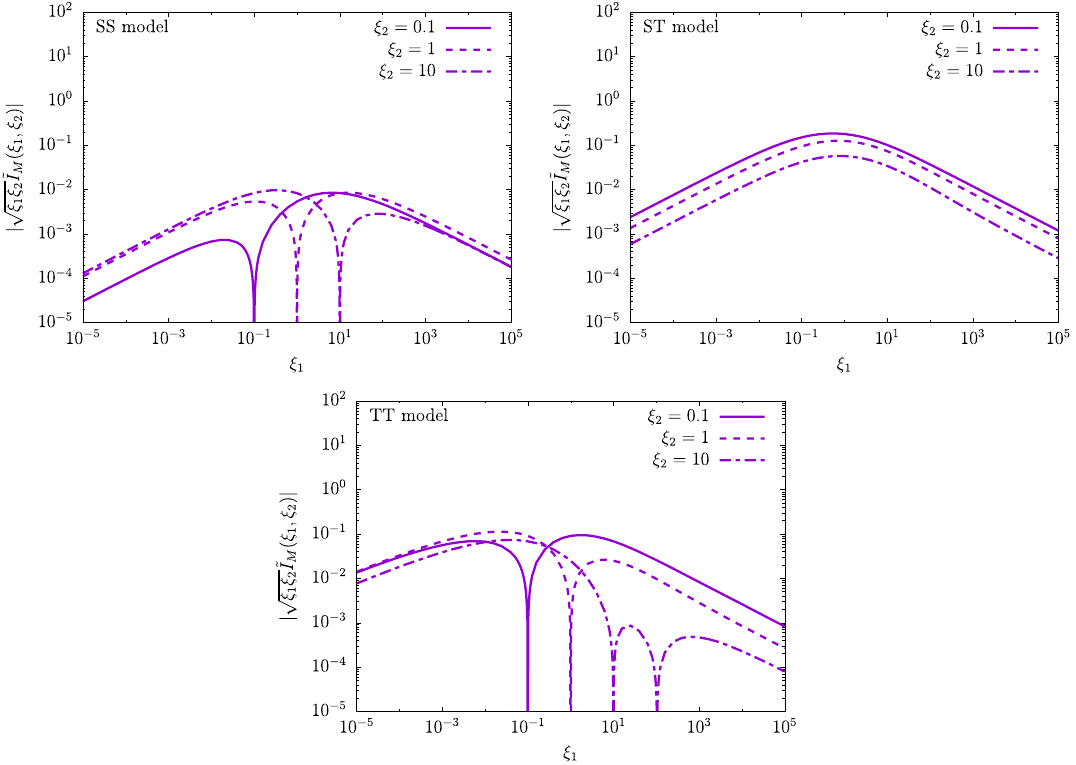
Figure 6 . Numerical evaluation of the loop functions where ξ 2 is fixed as ξ 2 = 0 . 1 , 1 , 10 in each plot and the other parameters are fixed as ξ H = ξ A = 1 and ξ α = ξ β = ξ ν